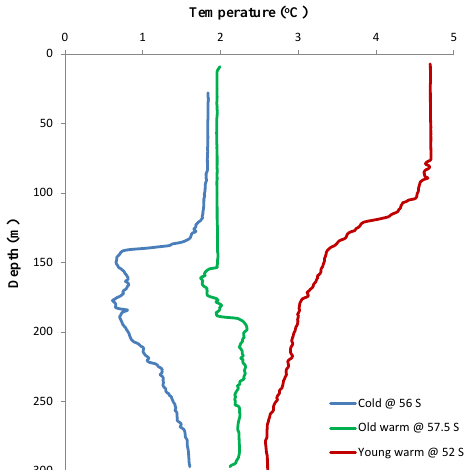
Figure 4. Upper 300m water column temperature profiles from CTD stations located at the approximate cores of the three main mesoscale features present along the transect lines: in blue the cold- core eddy (CTD station E1-3 in Table 1), in green the older warm- core eddy (E1-6) and in red the young warm-core eddy